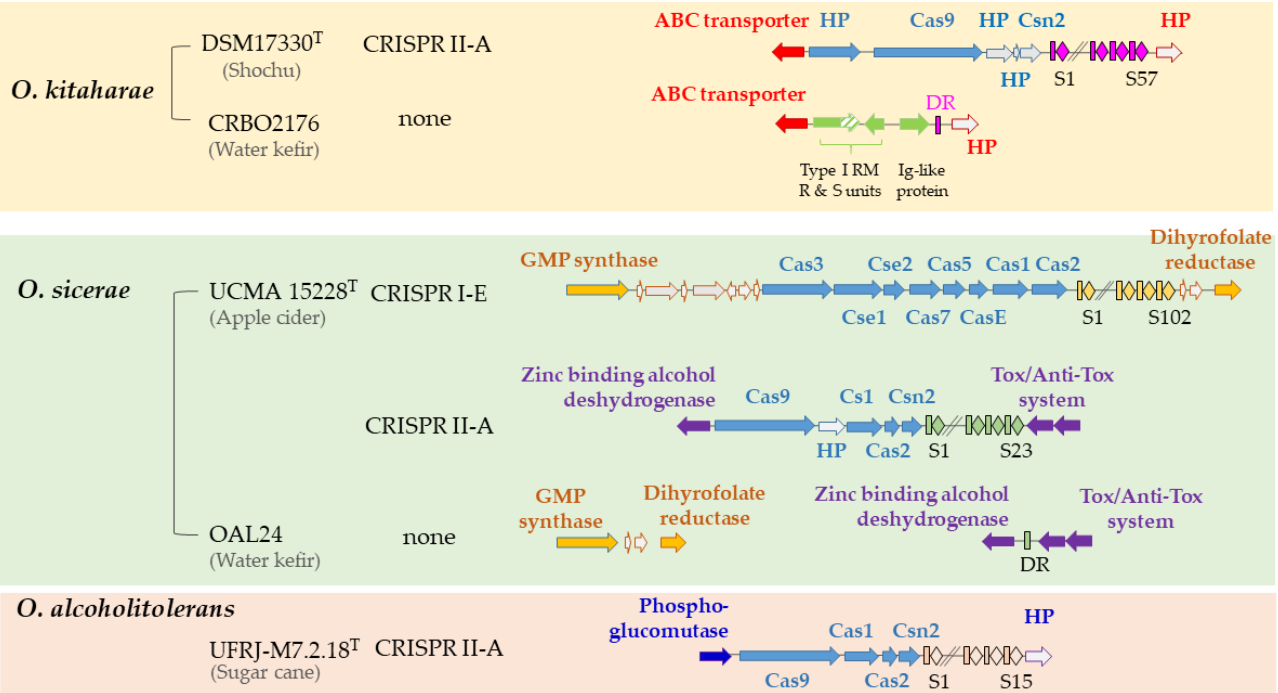
Figure 1. Distribution and architecture of CRISPR loci in the Oenococcus genus. Direct repeats (DR) and spacers are represented by rectangles and lozenges. Genes coding for hypothetical proteins (HP) are in grey. Double slash marks represent DNA regions that are not shown. Sequence ID for the restriction endonuclease R and S subunits and putative Ig-like proteins in O. kitaharae CRBO2176 are MCV3295975.1, MCV3295974.1 and MCV3295973.1, respectively.